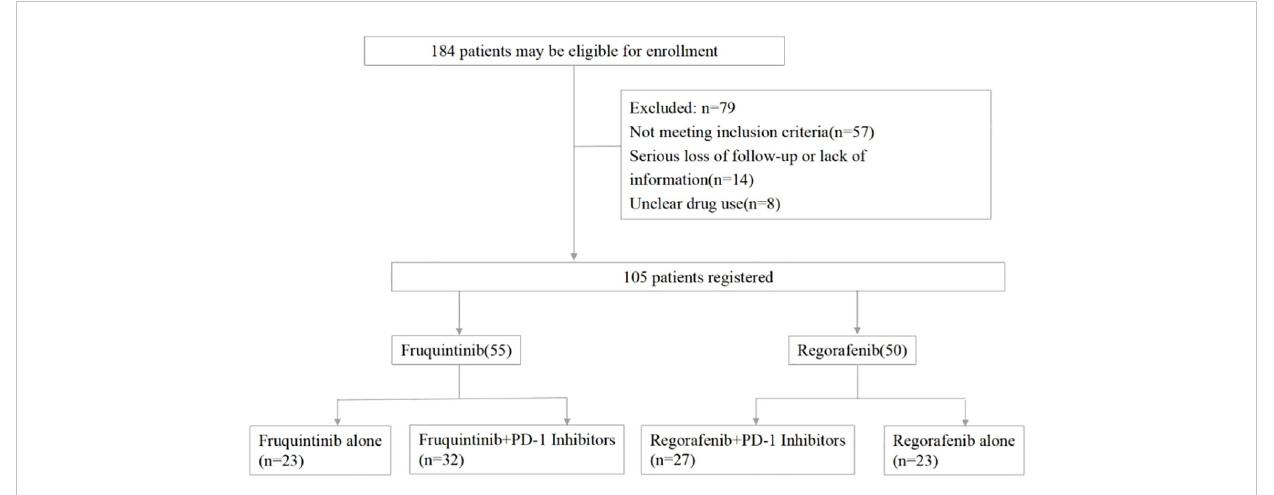
FIGURE 1 Flow diagram. PD-1, programmed death